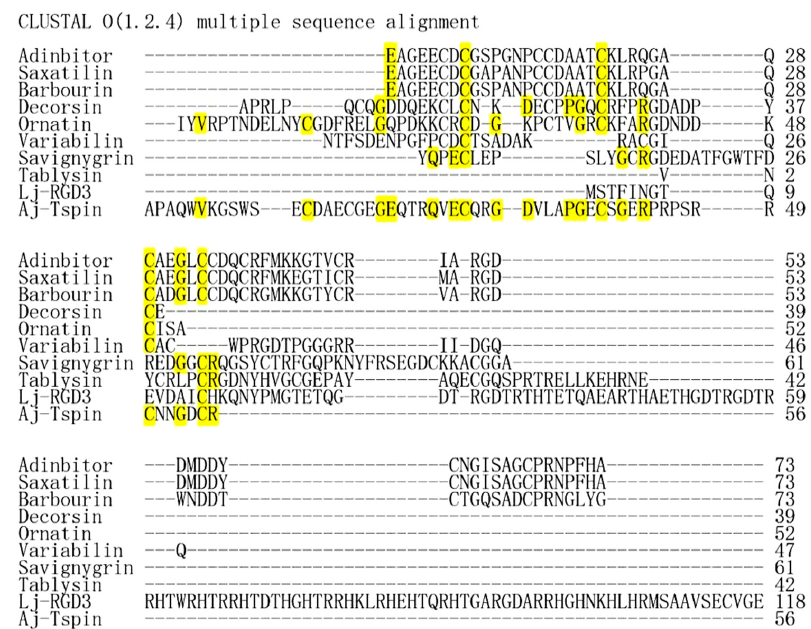
Figure 3. Multiple-sequence alignment of disintegrins from snakes, leeches, ticks, gadflies and lam-